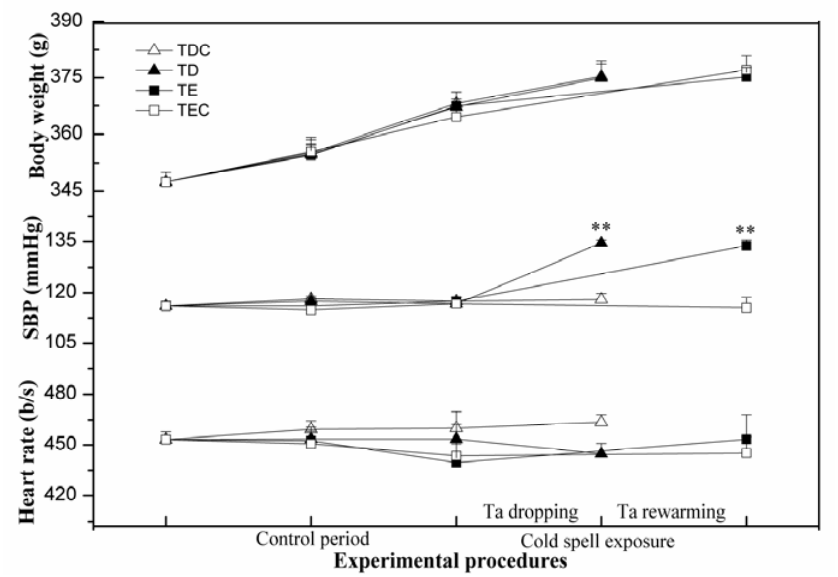
Figure 2. Variation in body weight, SBP, and HR of rats under controlled and cold air exposure periods. Data shown as mean + SE; n = 6 in each group. Compared with the control group, ** P < 0.005.